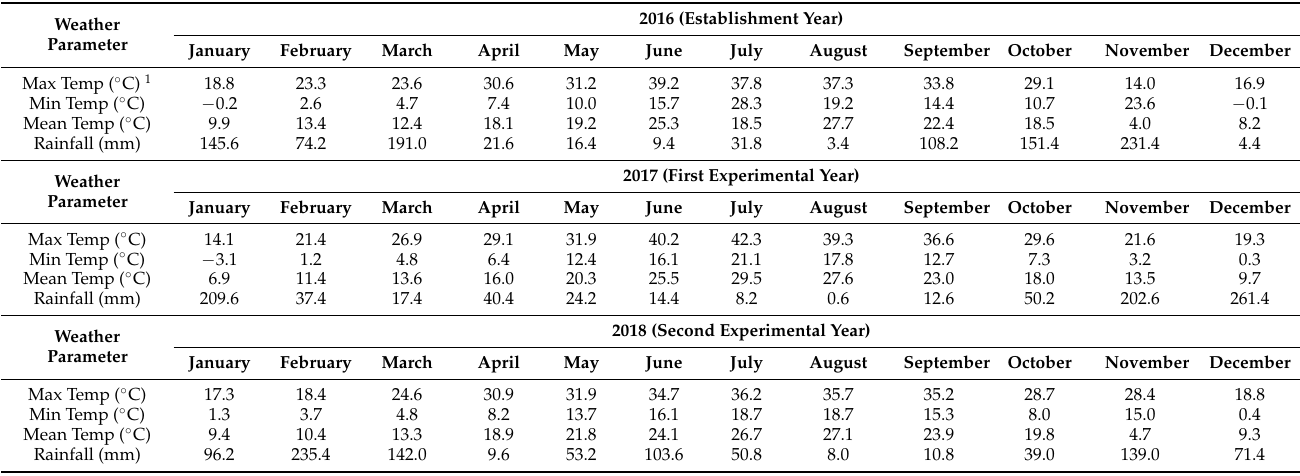
Table 1. Maximum monthly temperature, minimum monthly temperature, mean monthly temperature, and total monthly rainfall from 2016 to